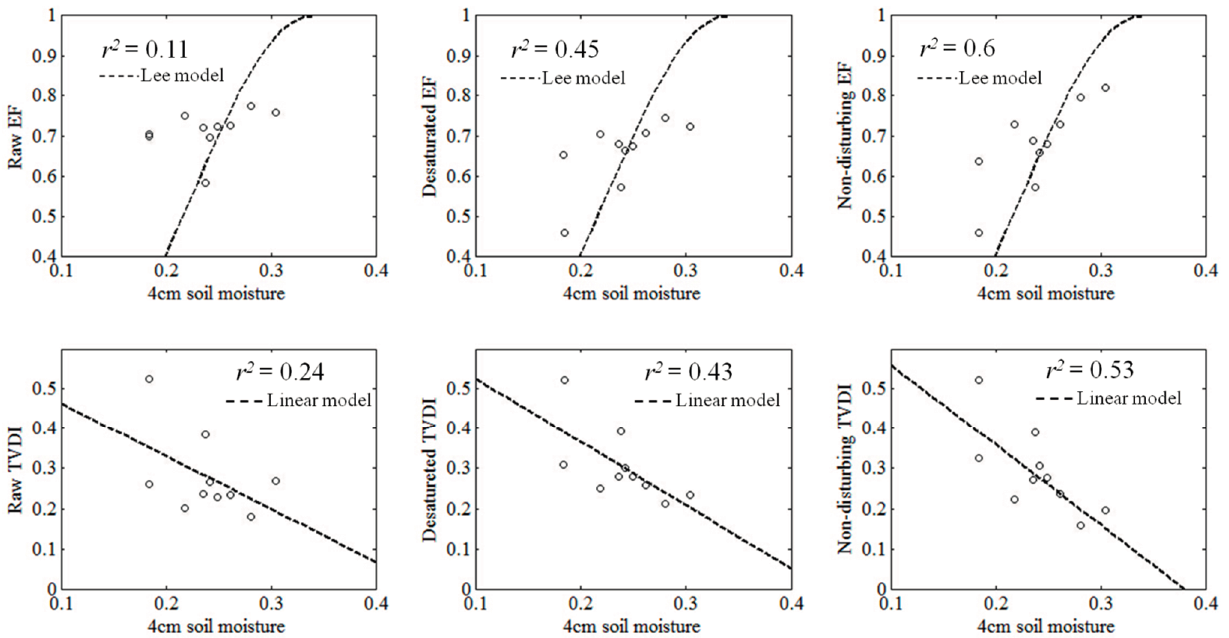
Figure 8. Correlation between the dryness indices and the SM measured at a depth of 4